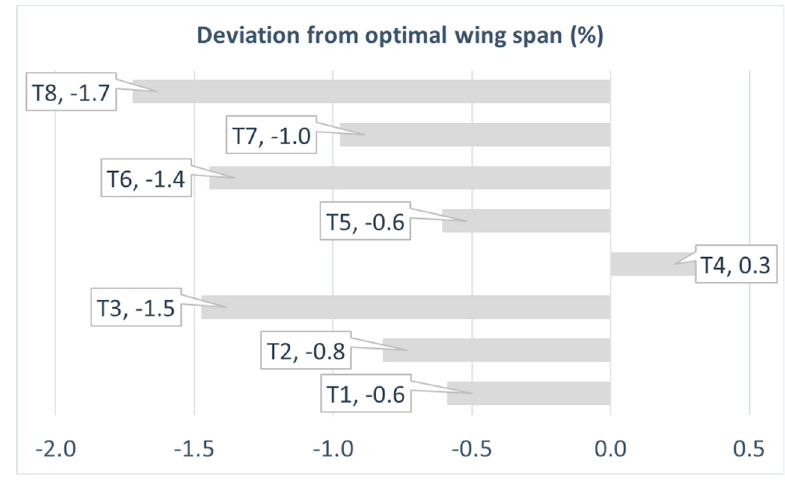
Figure 10. Technology sensitivity analysis: deviation from optimal wing span target value.